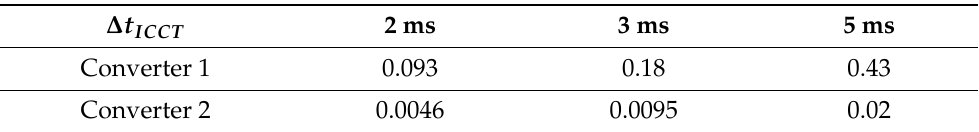
Table 12. Surge current integral ( MA 2 · s ) for D 2 with DC circuit-breakers for different internal current commutation times (ICCTs).